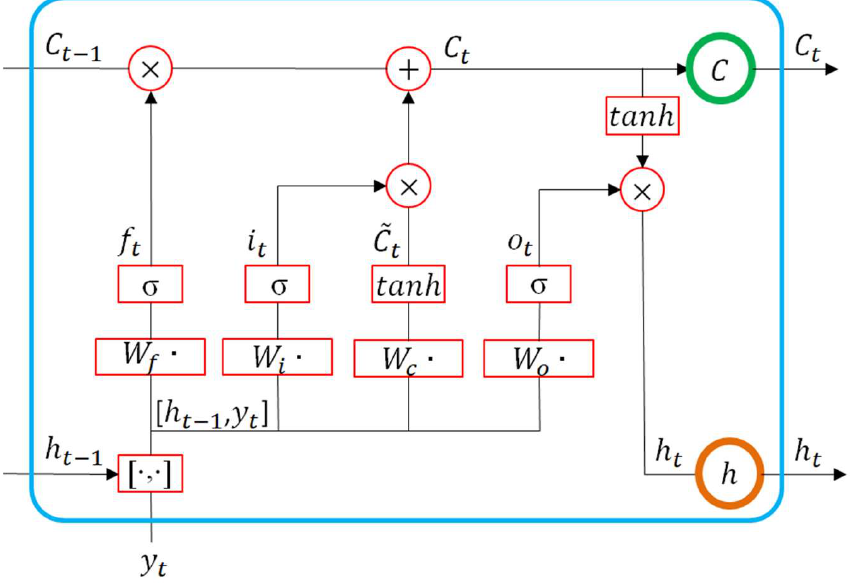
Figure 3. LSTM neural network and its unrolled form.